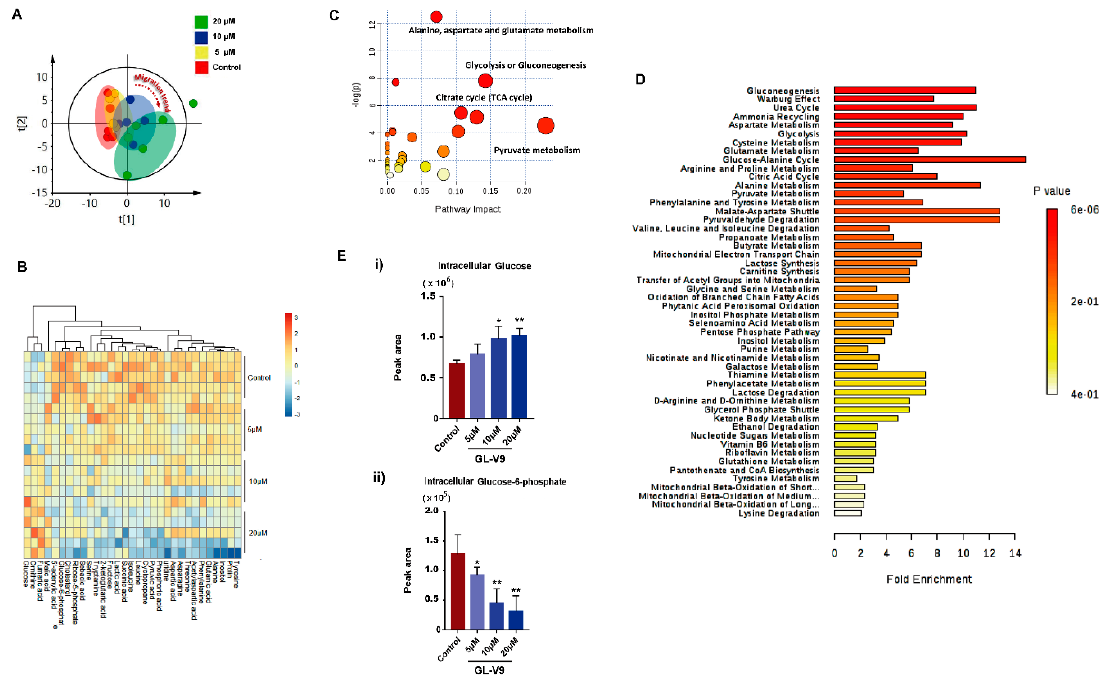
Figure 4. Overview and the pathway of the impact of A431 Cell on metabolites. ( A ) Heatmap of stromal molecular signatures of A431 Cell samples. ( B ) PCA plot of stromal molecular signatures of A431 Cell. Ellipses and shapes show clustering of the samples. ( C ) The pathway impact of A431 Cell on metabolites. The y -axis shows the p -values and the x -axis, the pathway impact values; the node color is based on its p -value and the node size reflects the pathway impact values. ( D ) The enrichment overview of the pathway-associated metabolite sets perturbed by acoustic trauma. ( E ) Peak area of glucose and glucose-6-phosphate in intracellular. Data is shown as average ± SD from three independent experiments. * p < 0.05 and ** p < 0.01 (comparison to the control).